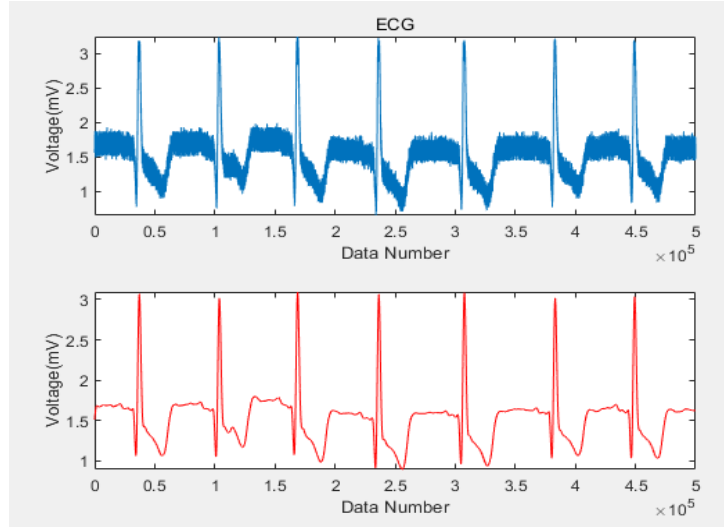
Figure 13. Noise removal using a MATLAB-based digital filter. The raw and filtered signals are shown in blue and red, respectively. The cutoff frequencies were set as 5, 250, and 60 Hz for low-pass, high-pass, and band-stop, respectively.